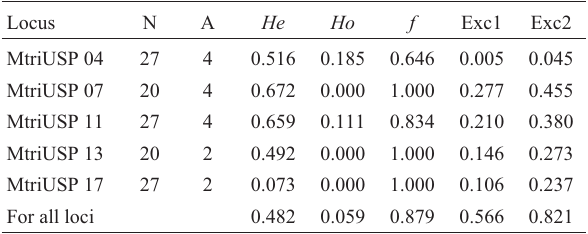
Table 1 - Number of Myrmecophaga tridactyla specimens (N), total number of alleles (A), observed ( Ho ) and expected ( He ) heterozygosity, inbreeding coefficient ( f ) and exclusion probability of the first (Exc1) and second (Exc2) parent for the five M. tridactyla microsatellite loci pooling all specimens sampled at Emas National Park, Brazil. All f -values were significantly different from zero at p < 0.01.